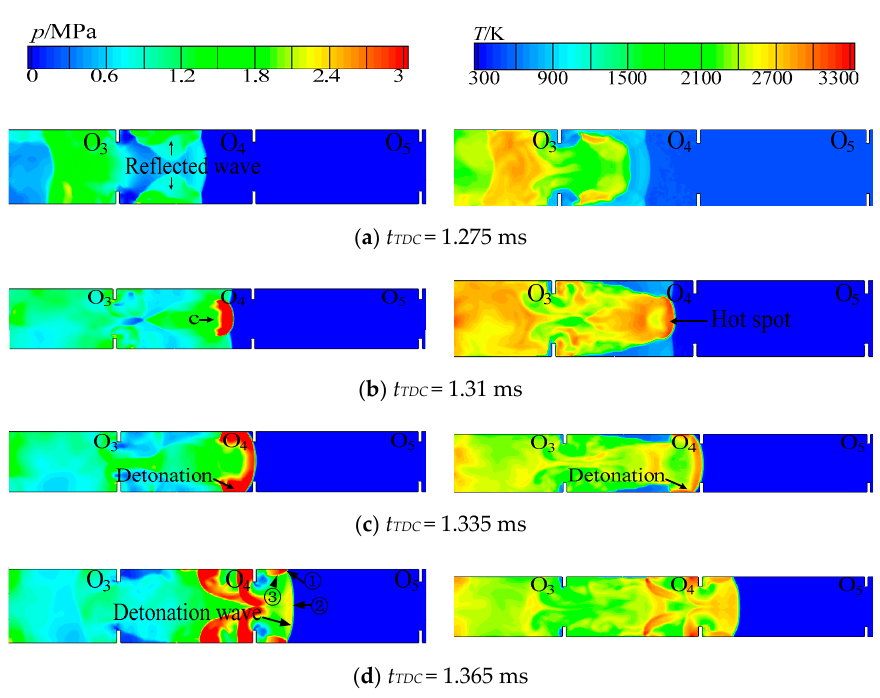
Figure 16. Variations of pressure and temperature field at deflagration-to-detonation transition (DDT) of wall ignition.